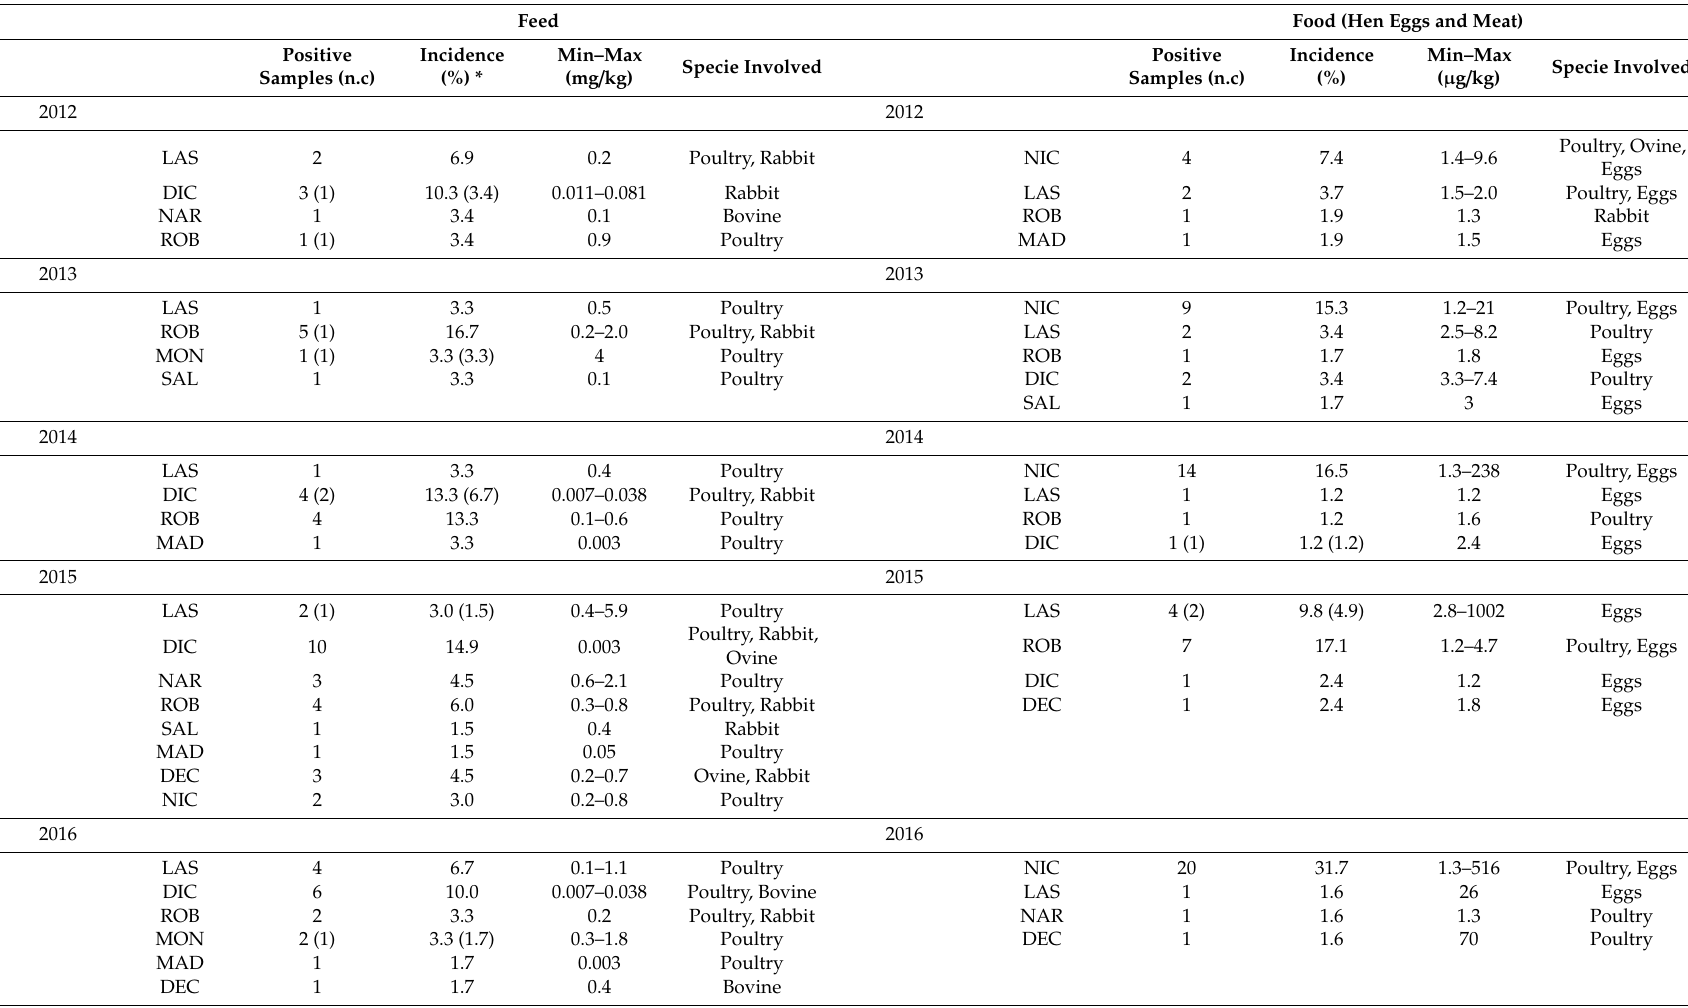
Table 3. Incidence of positive and noncompliant (n.c.) samples, residue concentration range in feed and food matrix collected within the Italian National Residue Control Plan during